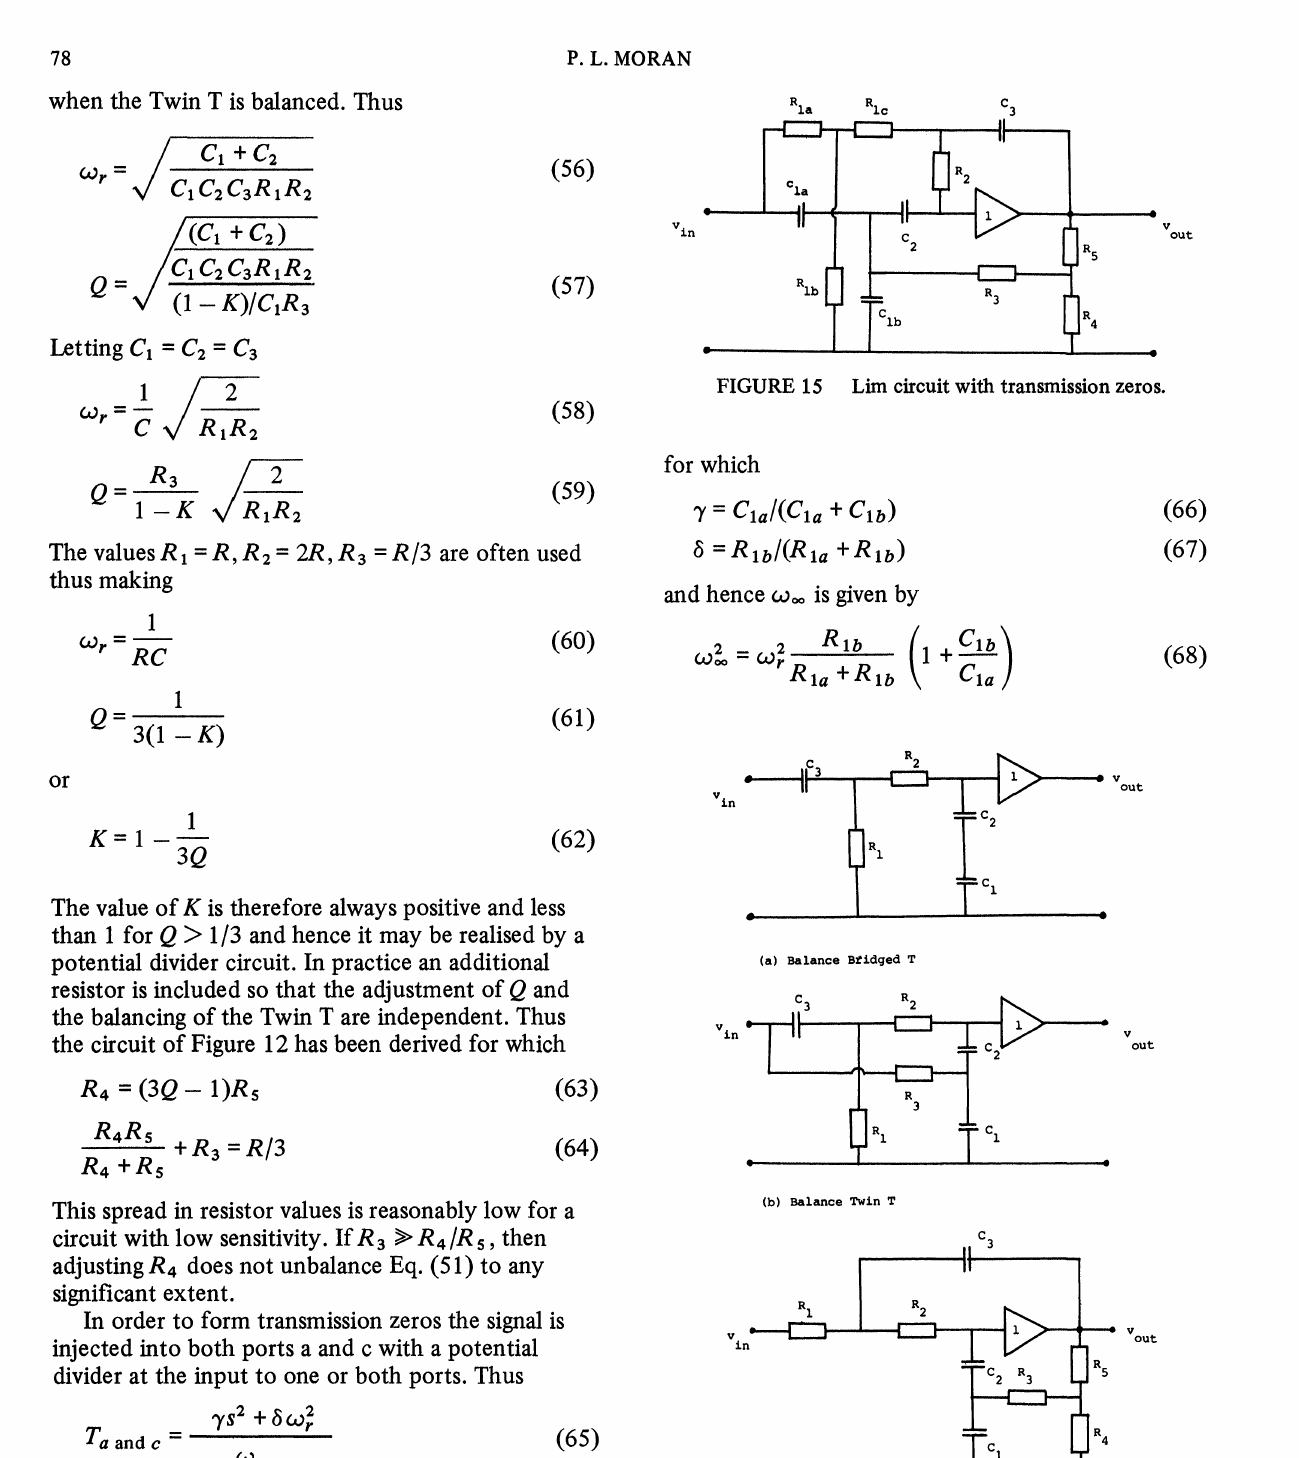
FIGURE 16 Adjustment subnetworks for Lim